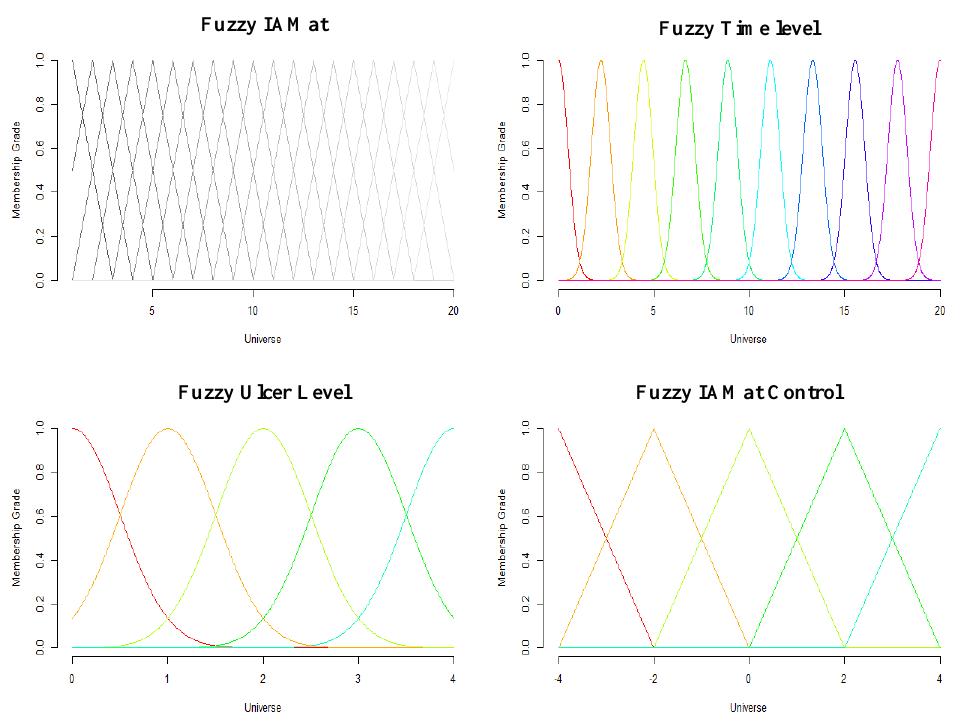
Figure 4. Fuzzy Membership Function of the Fuzzy Inference System used within the FICL model.